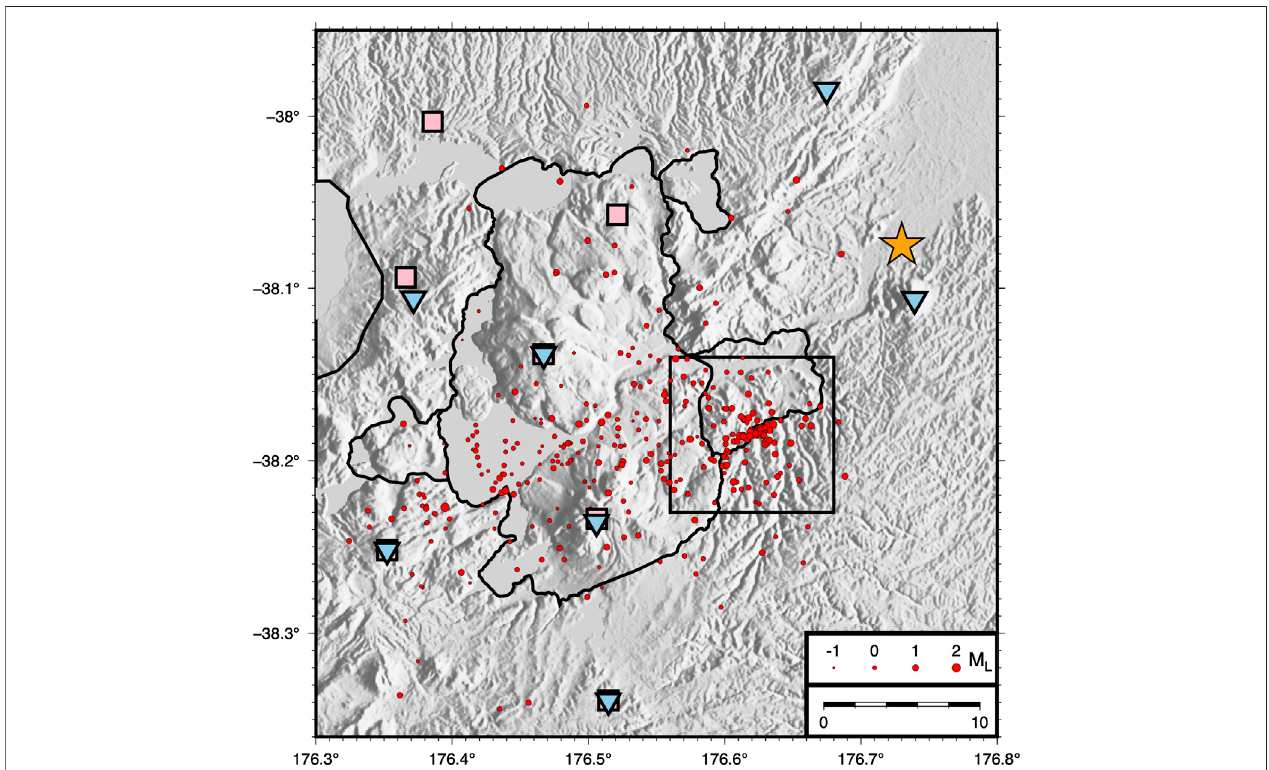
FIGURE2| Mapof348earthquakes(redcircles,scaledbymagnitude)thatoccurredintheOkatainaregionbetweenthe12th – 15thMarch2019.Theblueinverted triangles denote the seven short-period GeoNet seismometers used to detect and locate the earthquakes. Pink squares denote the location of the GeoNet GNSS network.Theblackboxshowsthelocationof Figure3 .TheorangestarmarksthelocationofKaweraugeothermal fi eld,wherethevelocitymodelusedinthisstudywas derived (Clarke et al., 2009, Figure S1).